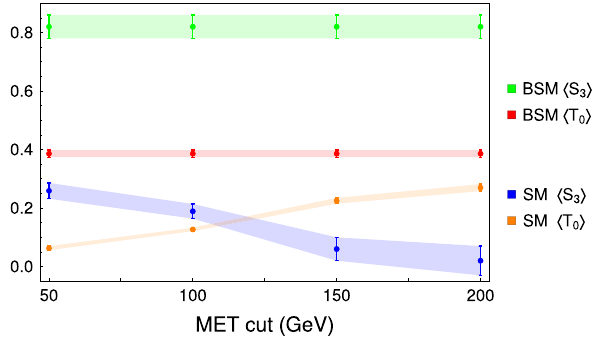
Fig. 1 SM predictions for (cid:3) S 3 (cid:4) and (cid:3) T 0 (cid:4) for Z + MET final states, as a function of the lower cut on MET. Above them, the same result from the BSM model described in the